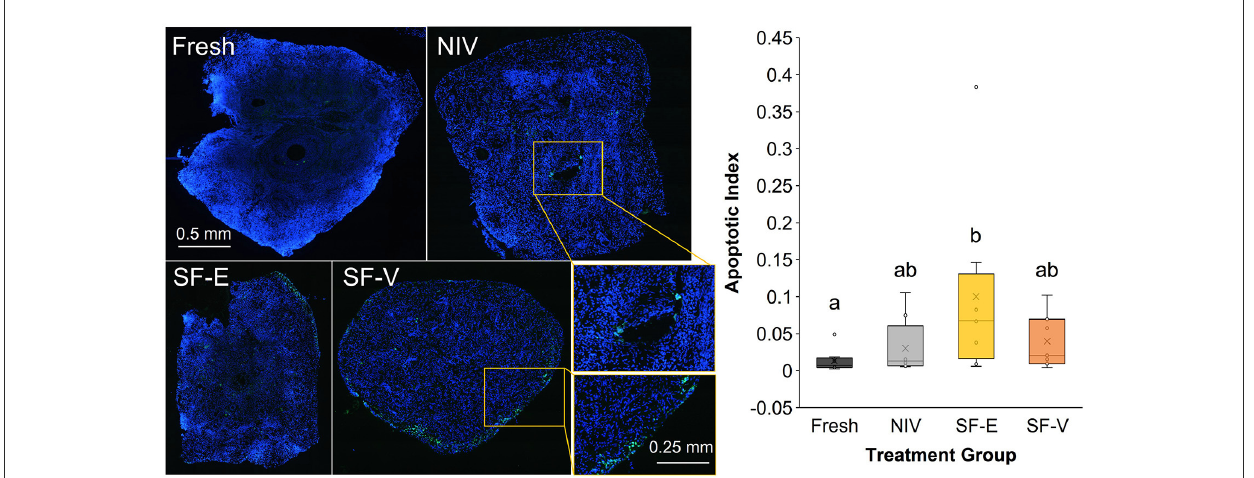
FIGURE6 TUNEL stain of fresh and cryopreserved [ via needle immersed vitrification (NIV), or slow freezing with either 7.5% DMSO and EG (SF-E), or 15% DMSO and EG with 0.5M sucrose (SF-V)] African painted dog ovarian tissues ( n = 8), with representative images displaying TUNEL positive cells in green, counterstained with blue DAPI (left) and relative ratio of fluorescence, or Apoptotic Index (right). Box-and-whisker plot displays median, quartile, and data range for follicle densities, with circles representing individuals, with letters indicating statistically significant differences among treatment groups following linear mixed model and post hoc Tukey HSD test ( p <